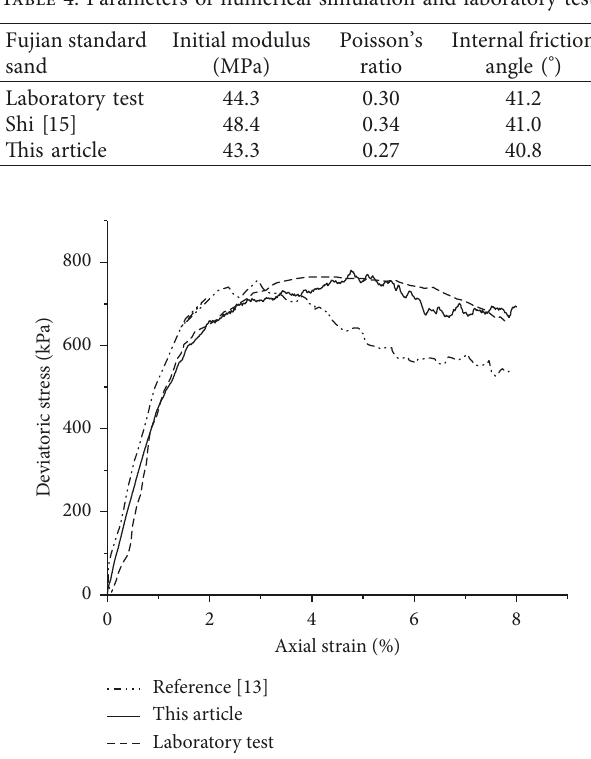
Figure 4: Curves of numerical simulation and laboratory test.